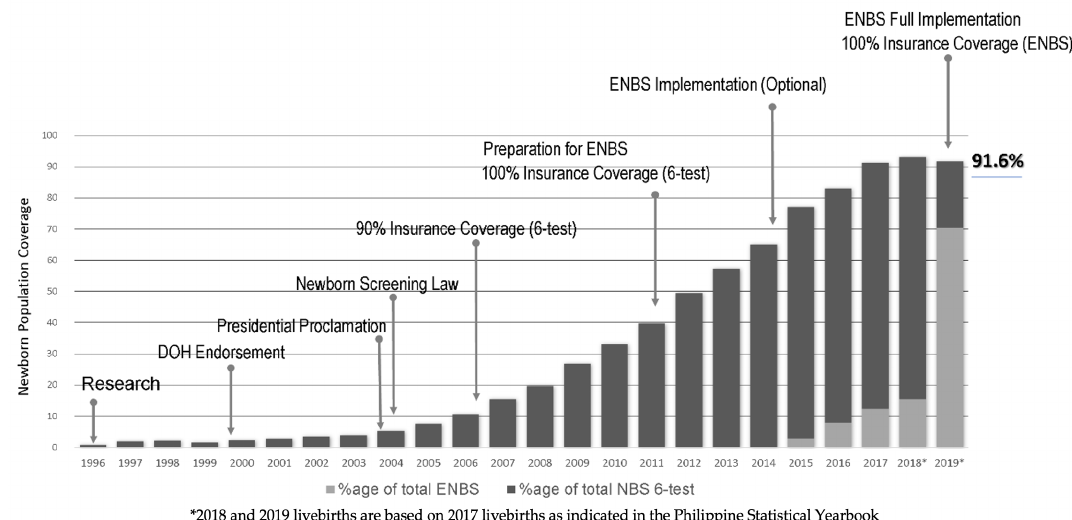
Figure 1. Annual trend in Philippine Newborn Bloodspot Screening (NBS) coverage and program